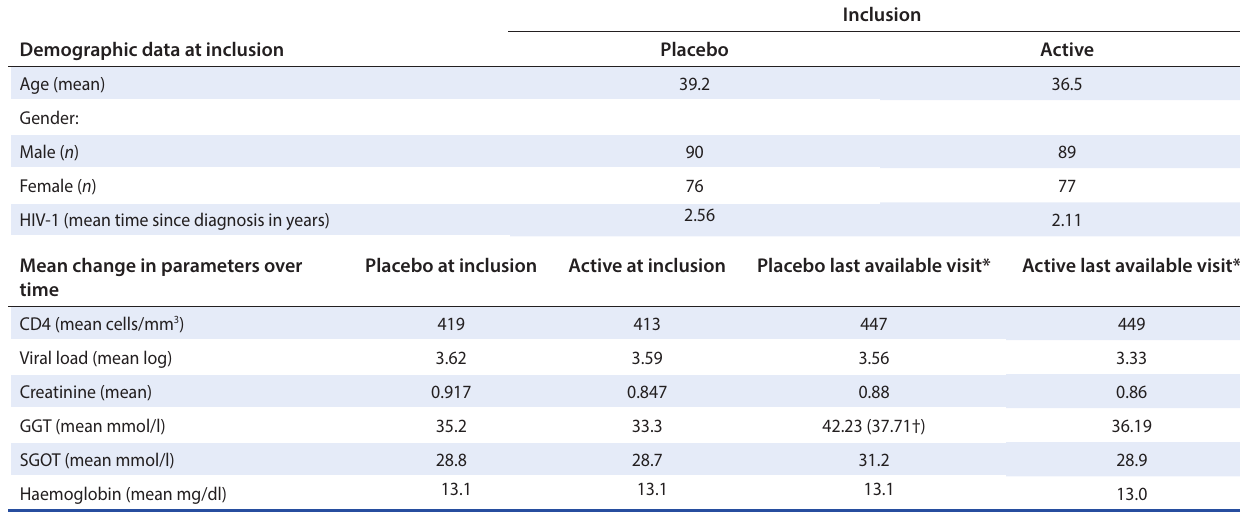
Table 1: Patient demographics at screening and last available visit